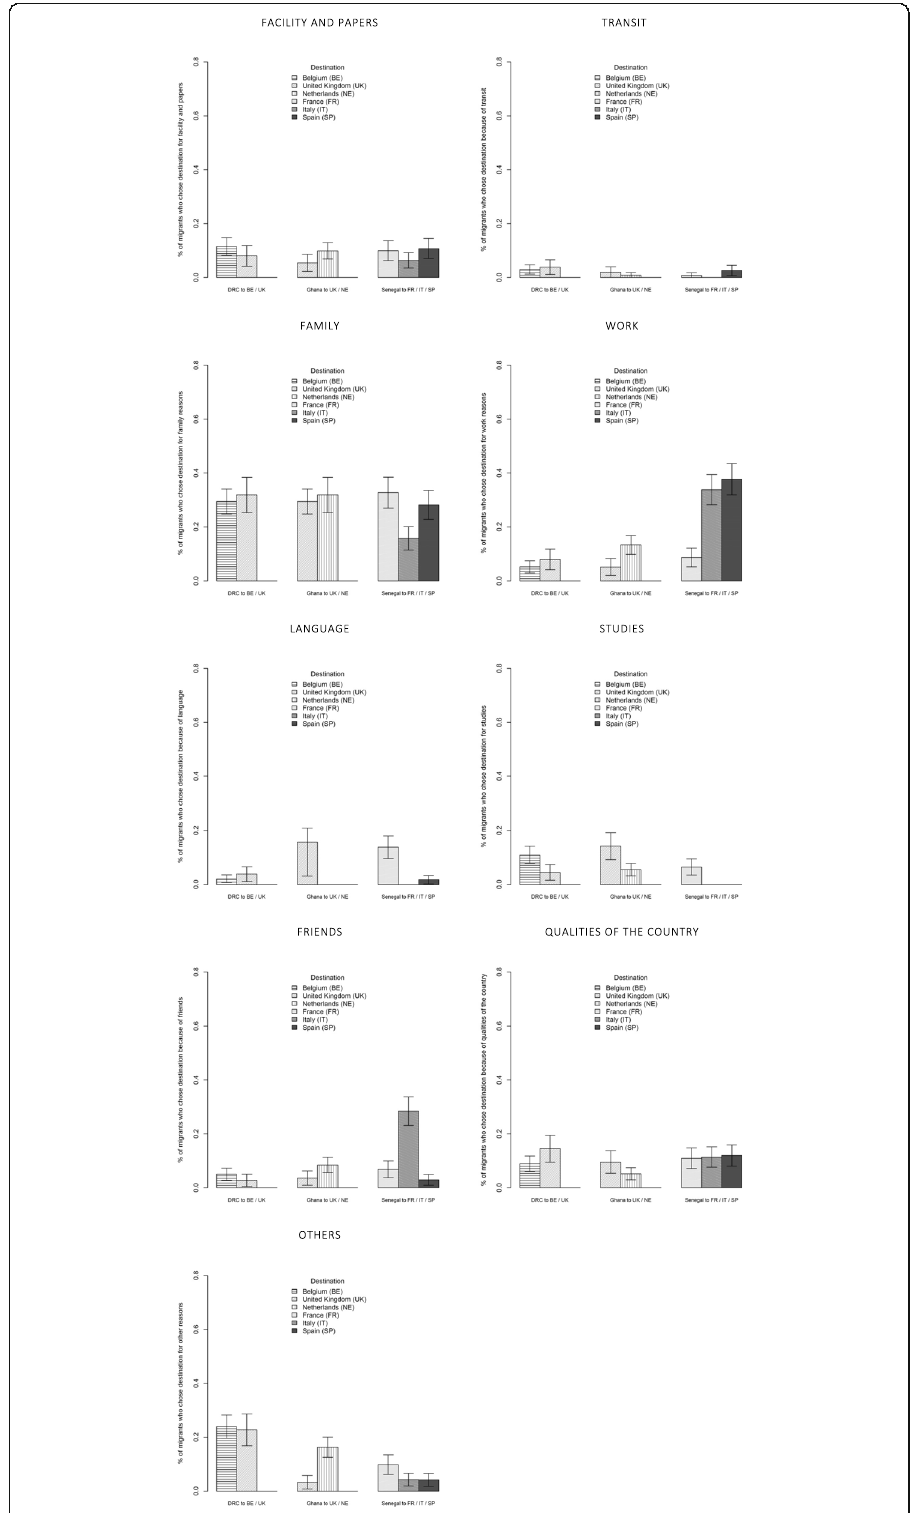
Fig. 9 (See legend on next